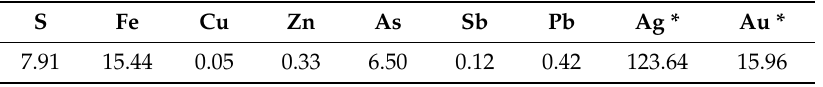
Table 1. Chemical analysis of the raw ore (mass fraction,